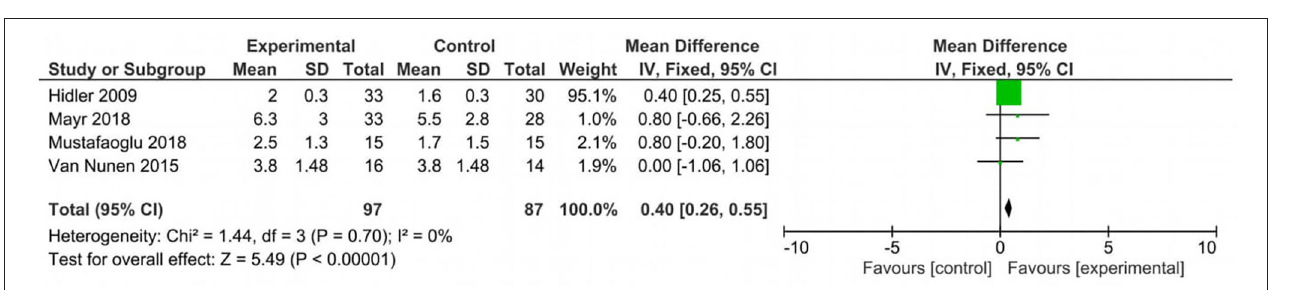
FIGURE 3 | Forest plot for the Timed Up and Go (TUG) test.